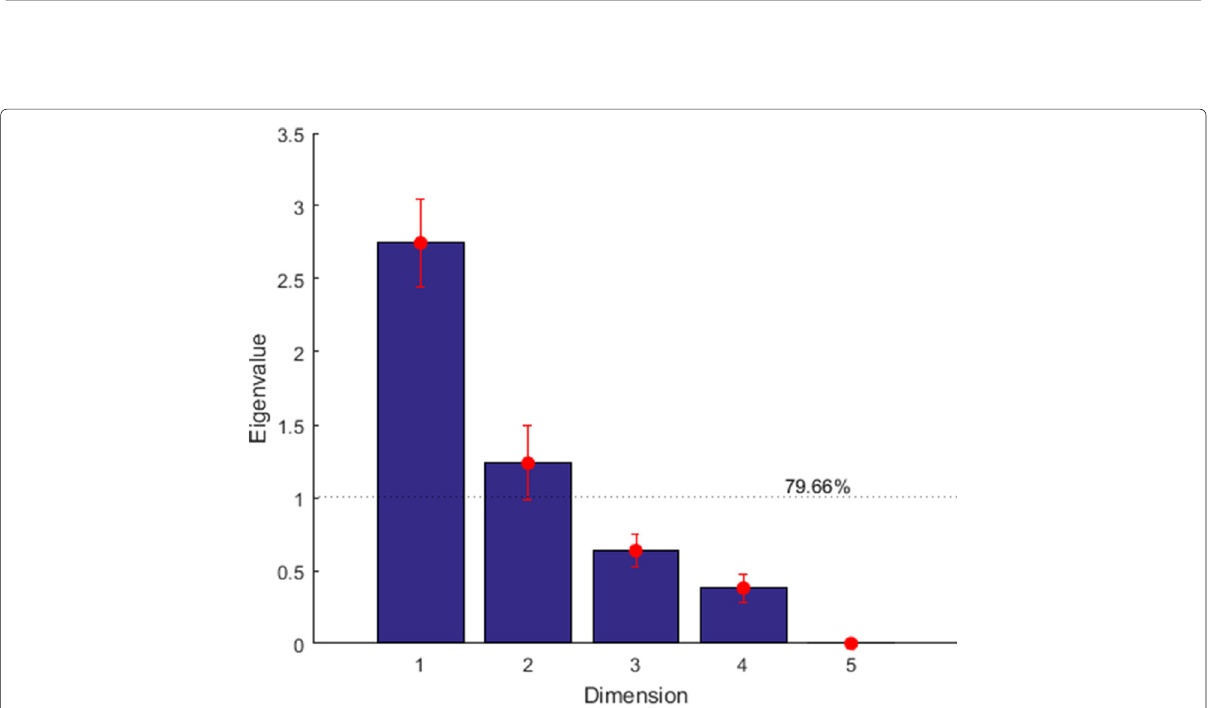
Fig. 5 Scree plot showing eigenvalues of the decomposition of the 5-dimensional partitioned dataset of the essential characteristics. The dottedline shows the Kaiser-Guttman reference line for eigenvalues>1, indicating that at least two of the five dimensions are relevant. These account for 79.66% of the total variance in the 5-dimensional dataset. Error bars show standard errors for 1000 bootstrap replicates of the CA